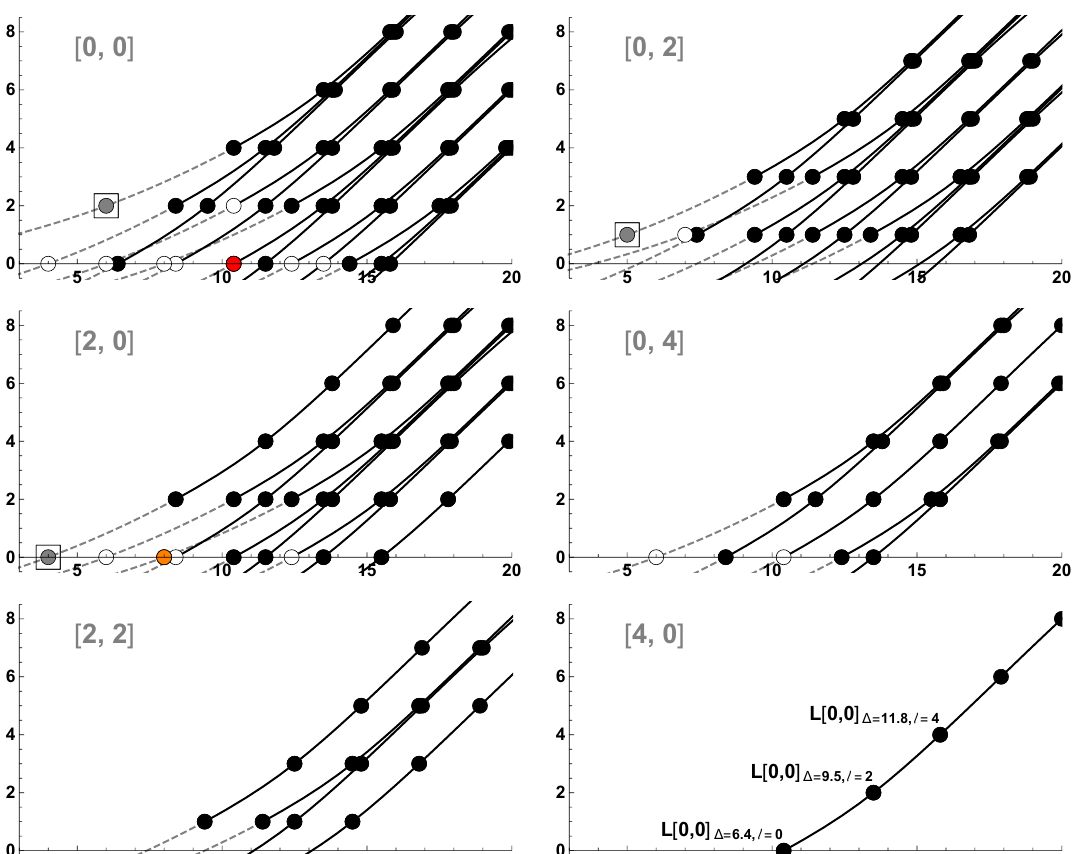
Figure 5. (∆ , ‘ ) planes: leading L [0 , 0] ∆ ,‘ trajectory (lines and dots) and D [2 , 0] operators (squares).